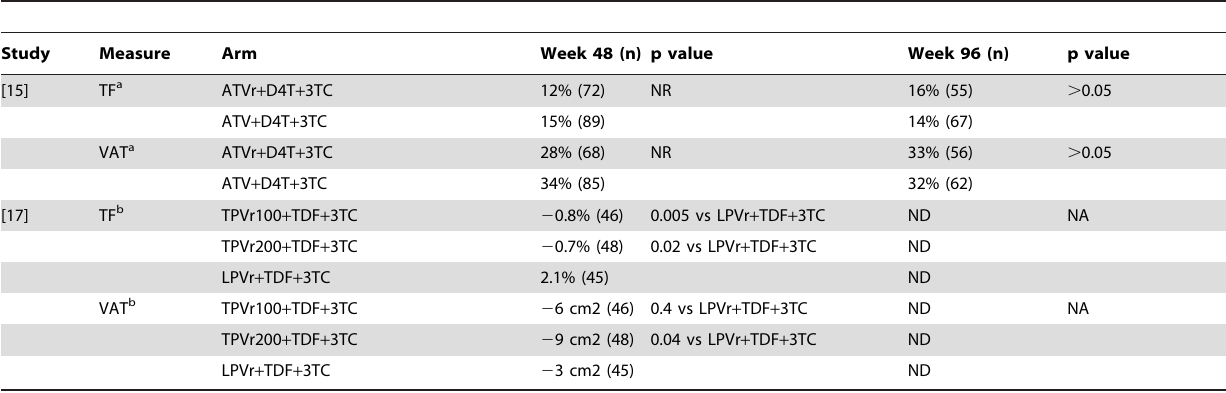
Table 15. Change from baseline in trunk fat (TF) on DEXA scan, and visceral adipose tissue (VAT) on CT scan: PI versus PI.